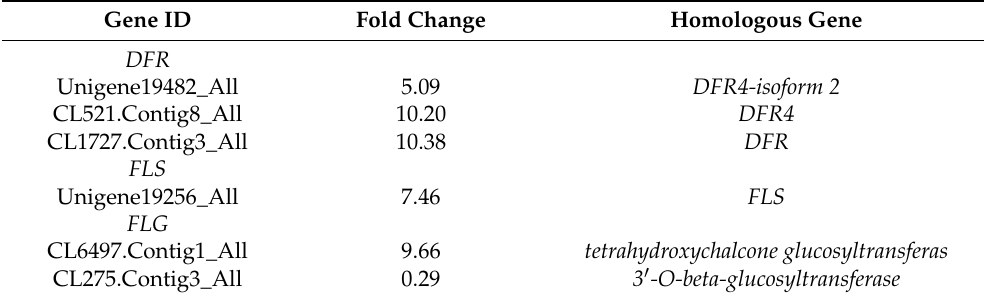
Table 9. The upregulated DEGs related to flavonoids in the roots of A. canescens under 100 mM NaCl, but not under control conditions, for 6 h.